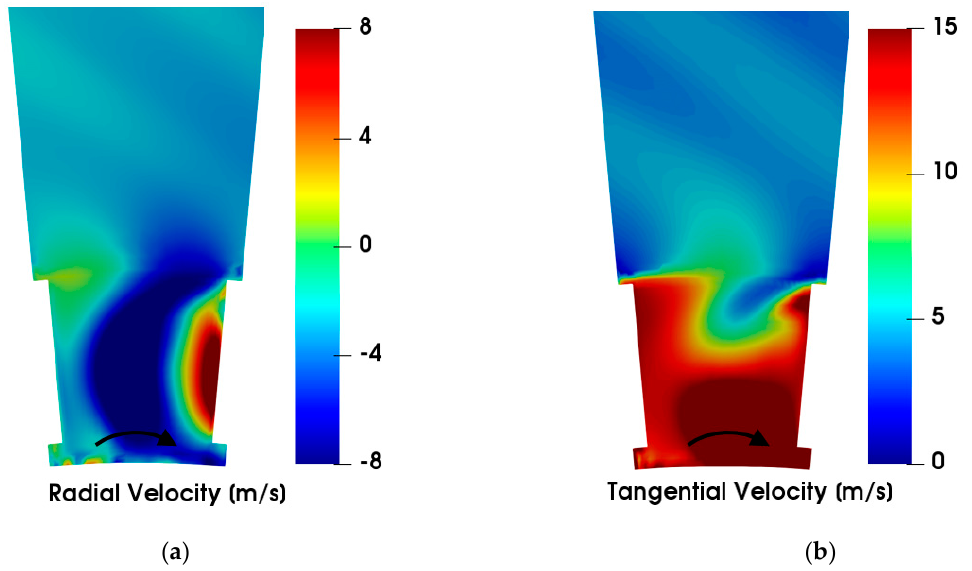
Figure 5. Contours of velocity in front of and between classifier blades at a classifier speed of 900 rpm and no solid load ( a ) radial component; ( b ) tangential component.